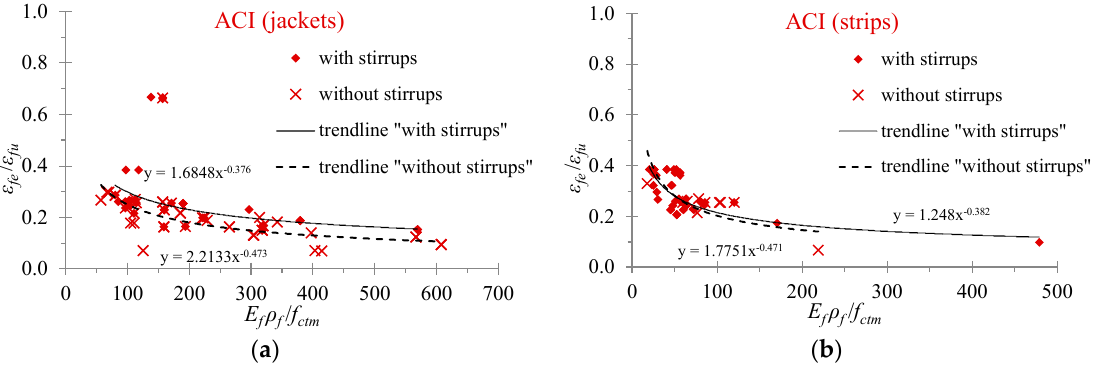
Figure 11. Effectiveness of the EB-FRP U-jacketing based on the provisions of the ACI Committee 440: ( a ) U-shaped retrofitted T-beams with EB-FRP jackets; ( b ) U-shaped retrofitted T-beams with EB-FRP strips.